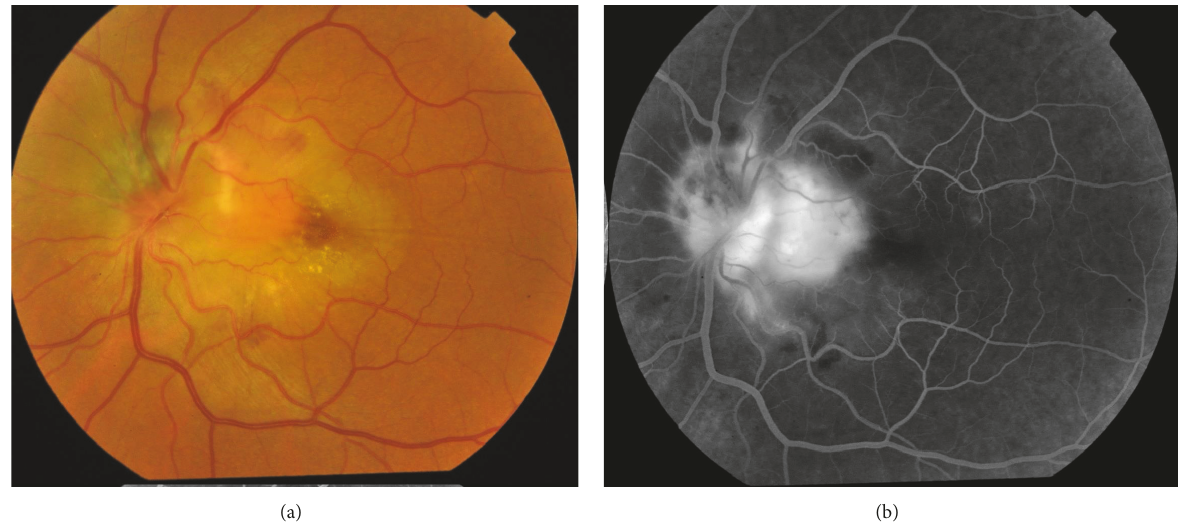
Figure 1: (a) Fluorescein angiography of the left eye showing early hyperfluorescence in the temporal juxtapapillary region. (b) Fundus photography of the left eye.